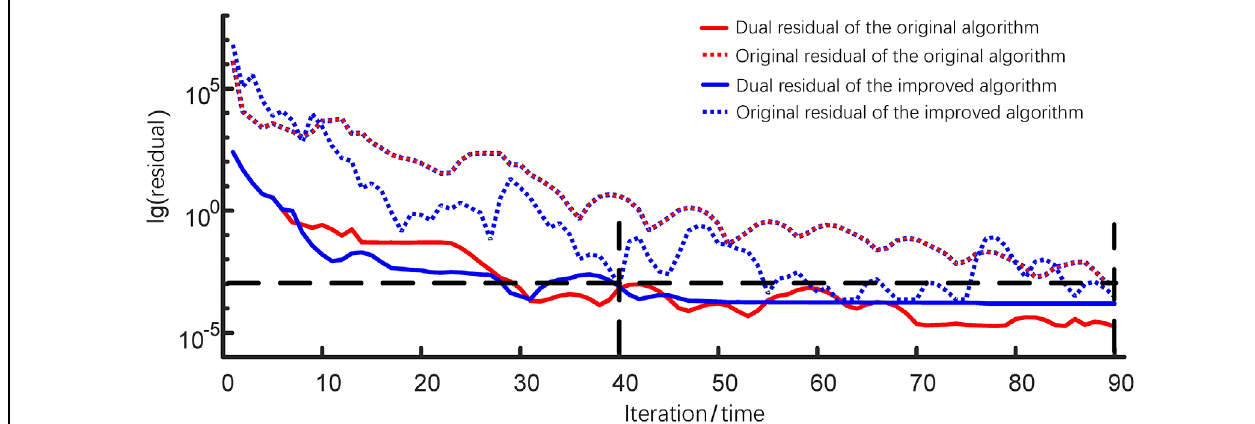
FIGURE 12 | Comparison of the residual convergence in the distributed